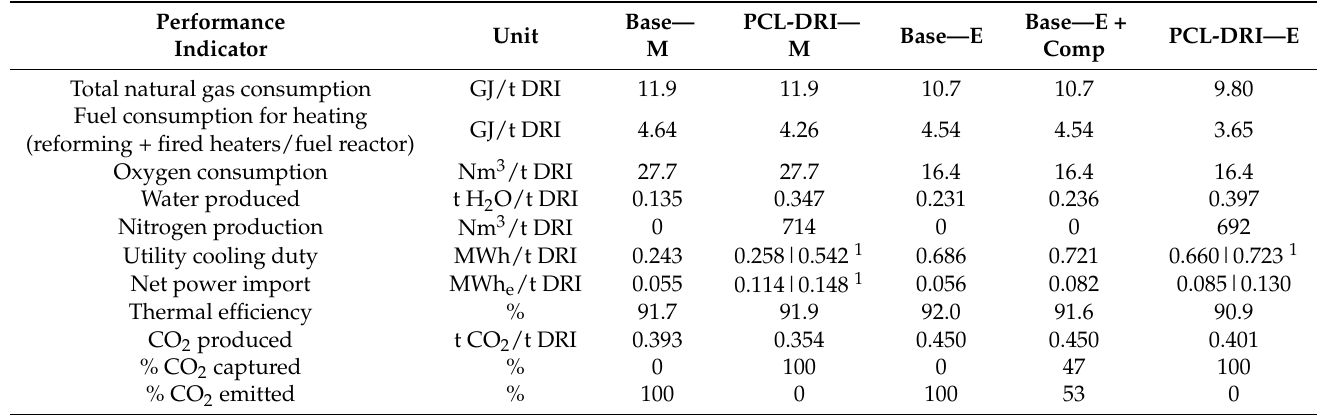
Table 8. Comparison of key performance indicators between base cases and PCL-DRI